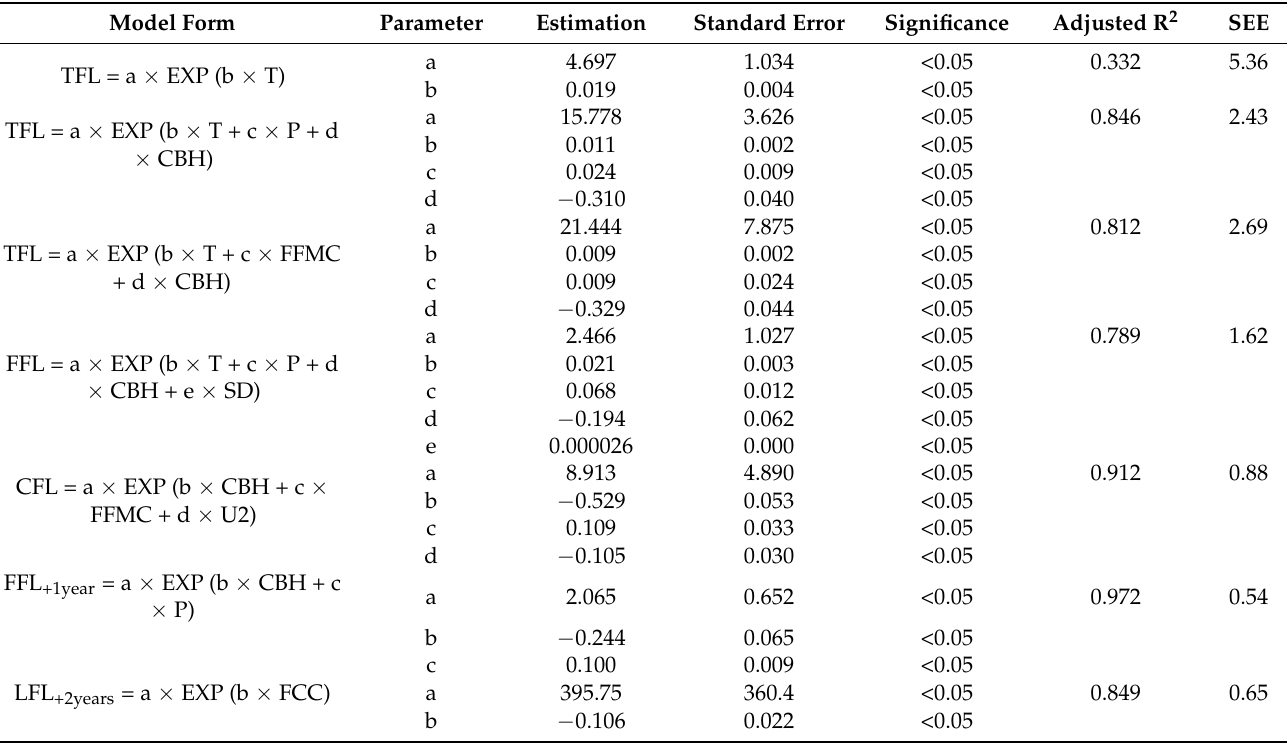
Table 5. Fuel dynamics models obtained using statistical